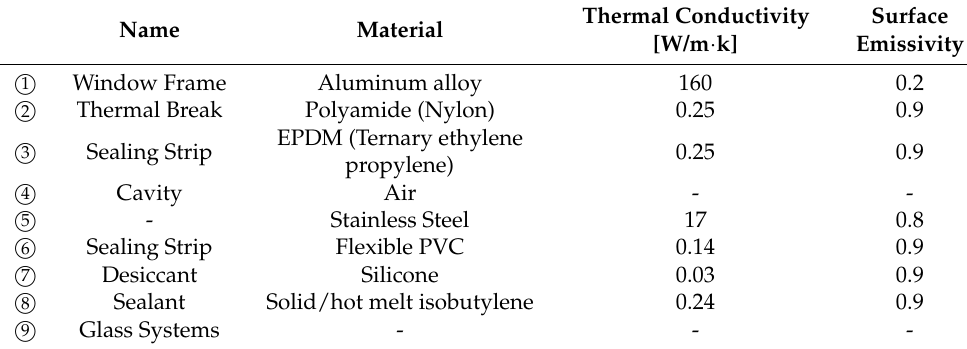
Figure 6. Typical thermal model of broken-bridge aluminum window frame. Table 1. Window frame materials.